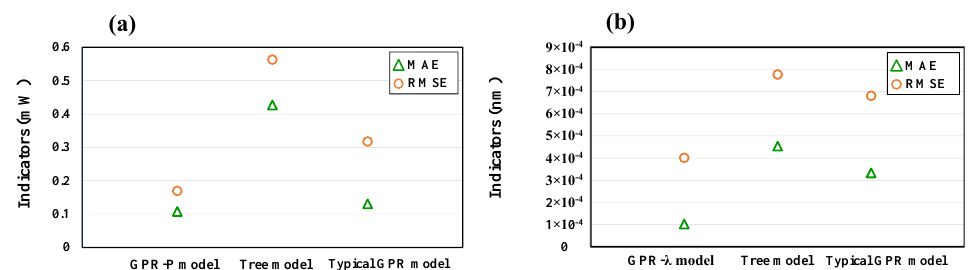
Figure 8. Indicators of using different models in power and wavelength prediction. ( a ) Indicators in power prediction. ( b ) Indicators in wavelength